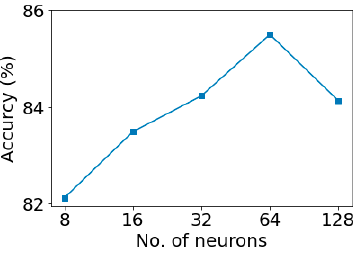
Figure 10. Performance of 1D CNN by varying the number of hidden layer neurons.